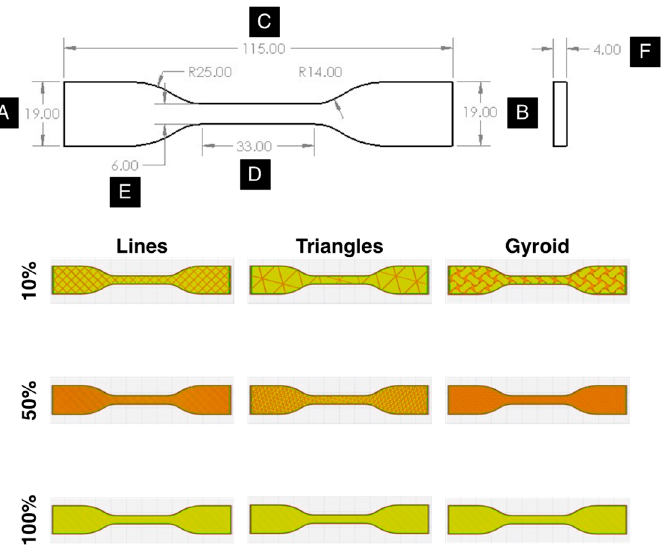
Figure 2. Tensile specimen geometry (with dimensional measurements A through F in mm) based upon the ASTM D638-14 Type IV speci fi cations, alongside specimen cross sections used in Phase 2 for each in fi ll density and in fi ll pa tt ern. for each infill density and infill